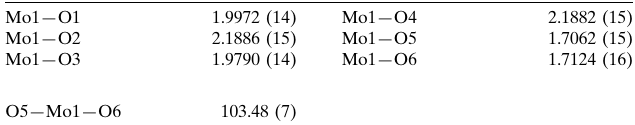
Selected geometric parameters (A˚ , (cid:2) ).